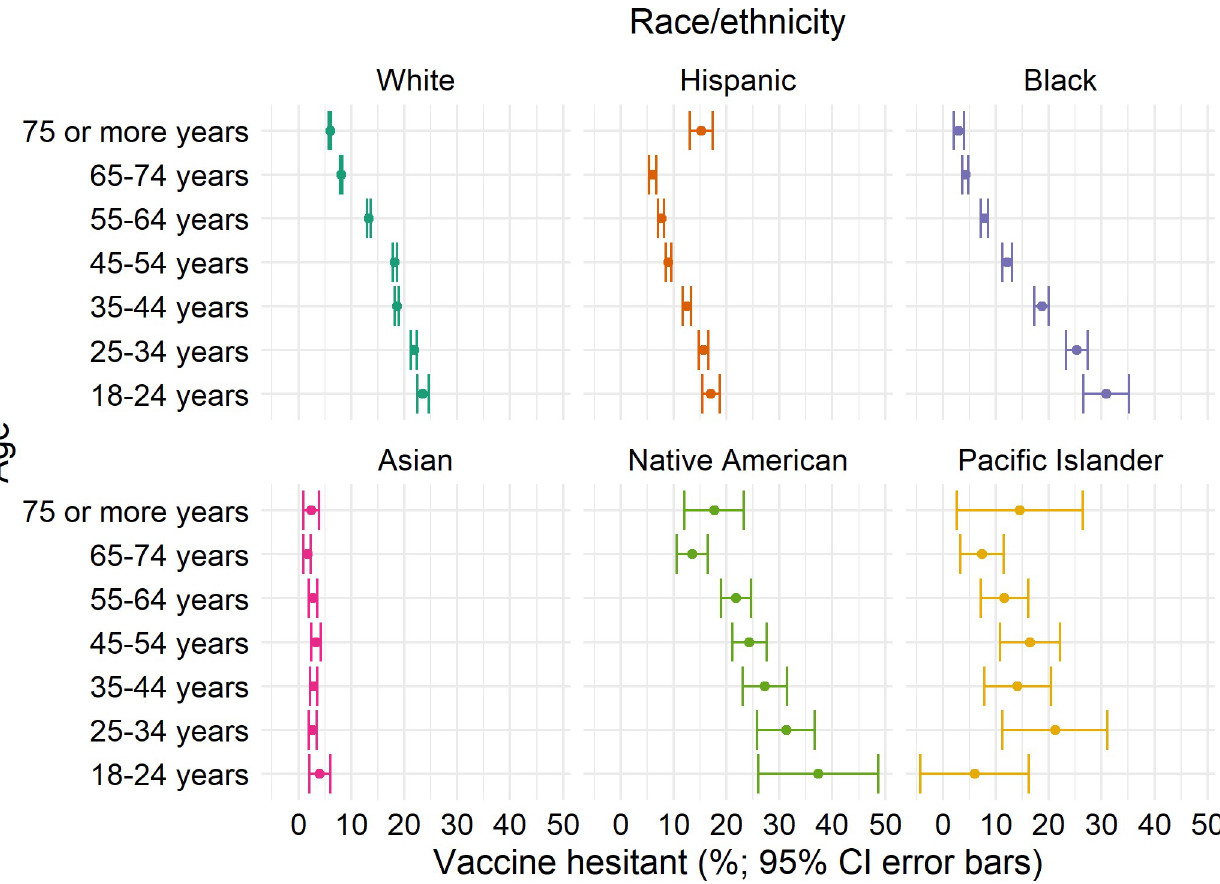
Fig 3. COVID-19 vaccine hesitancy by age group, stratified by race/ethnicity, among US adults, May 2021. Differences in hesitancy by age (e.g., 18–24 year-olds versus 65–74 year-olds) were more pronounced in Blacks (RR = 7.26 [95%CI, 5.92, 8.61]) versus Whites (RR = 2.89 [95% CI 2.75, 3.04]) or other race/ethnicity groups. Asians had hesitancy < 5% hesitancy in all age groups. Differences in hesitancy by race/ethnicity were more pronounced in younger adults and adults � 75 years.